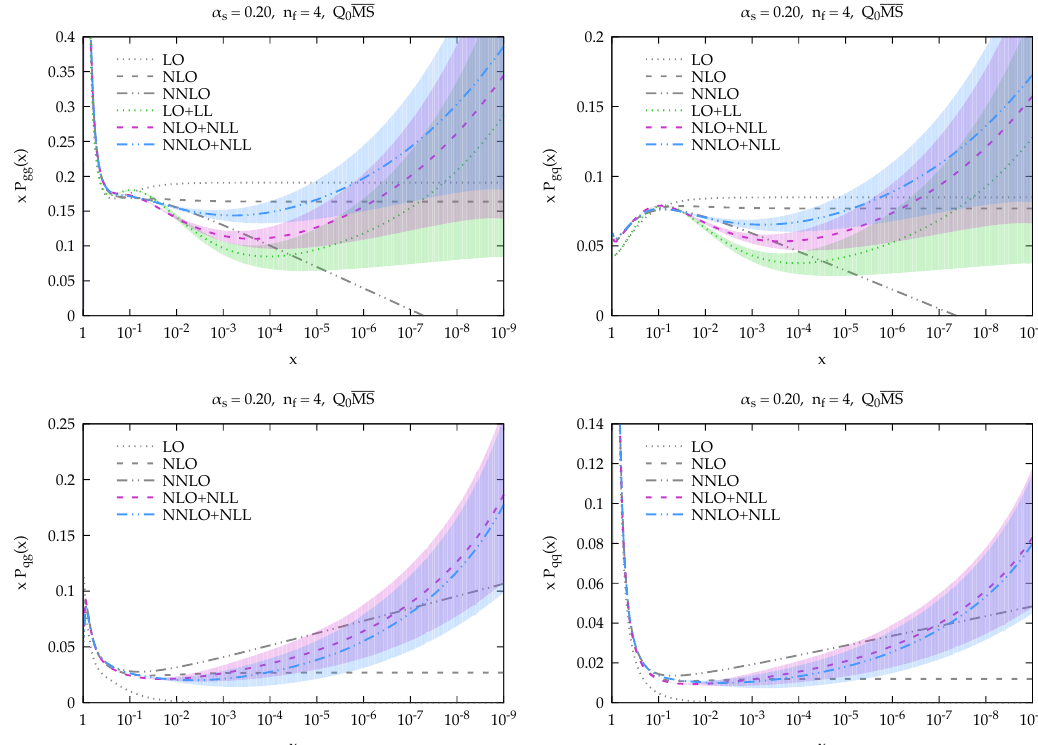
Figure 2 . The resummed and matched splitting functions at LO+LL (dotted green), NLO+NLL (dashed purple) and NNLO+NLL (dot-dot-dashed blue) accuracy: P gg (upper left), P gq (upper right), P qg (lower left) and P qq (lower right). The (cid:12)xed-order results at LO (dotted) NLO (dashed) and NNLO (dot-dot-dashed) are also shown (in black). The results also include an uncertainty band, as described in the text. The plots are for (cid:11) s = 0 : 2 and n f = 4 in the Q 0 MS scheme. We note that di(cid:11)erence between Q 0 MS and MS for the (cid:12)xed-order results is immaterial at this